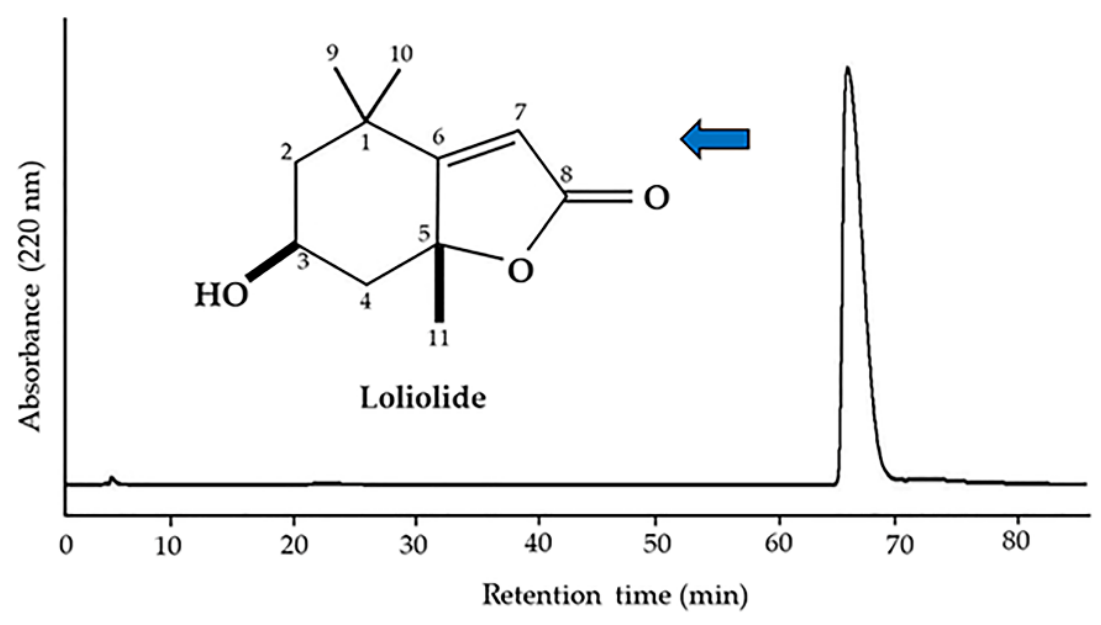
Figure 4. HPLC chromatogram and chemical structure of Figure 2. HPLC chromatogram and chemical structure of loliolide.